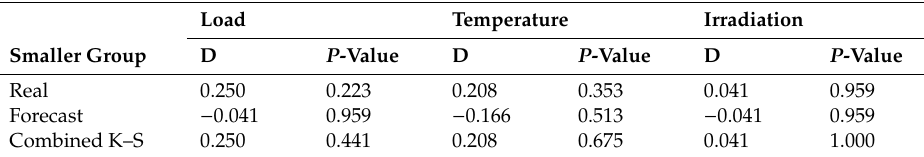
Table A4. Kolmogorov–Smirnov (K–S) test